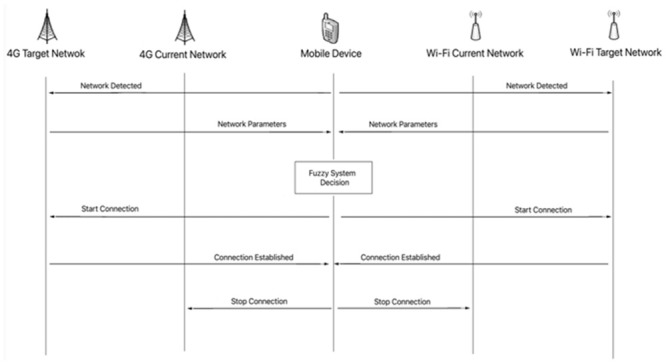
Signaling handover.